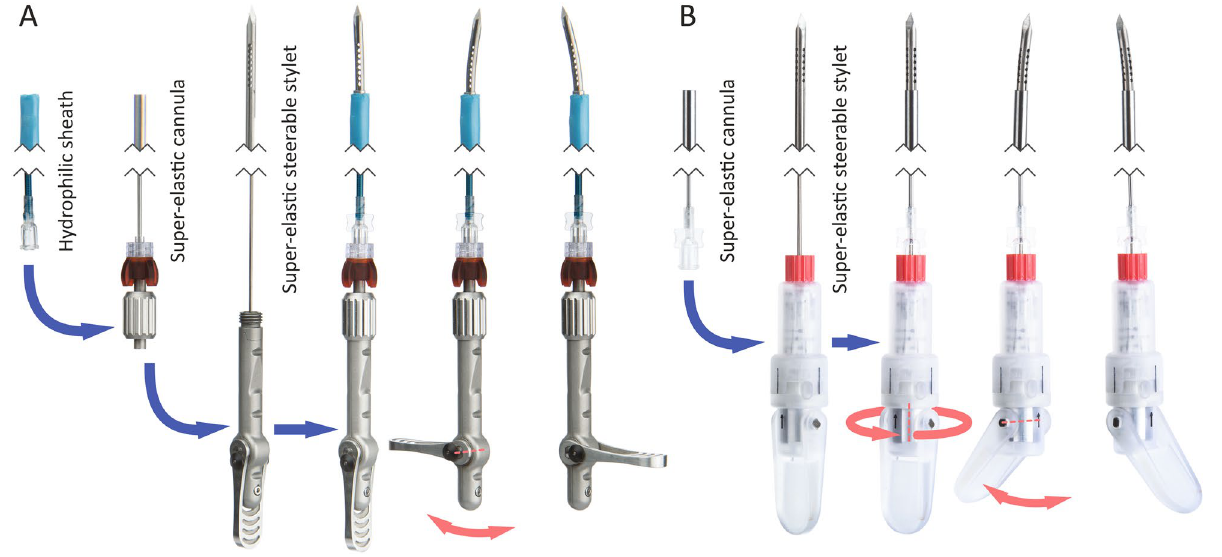
Figure 1. Modular designs of v1 planar ( A ) and v2 omnidirectional ( B ) steerable needles, with hydrophilic sheaths and nitinol stylets and cannulas. Compliant joints enable tip articulations of approximately 11°. Assembly steps are shown with blue arrows, and degrees of freedom in actuation with red